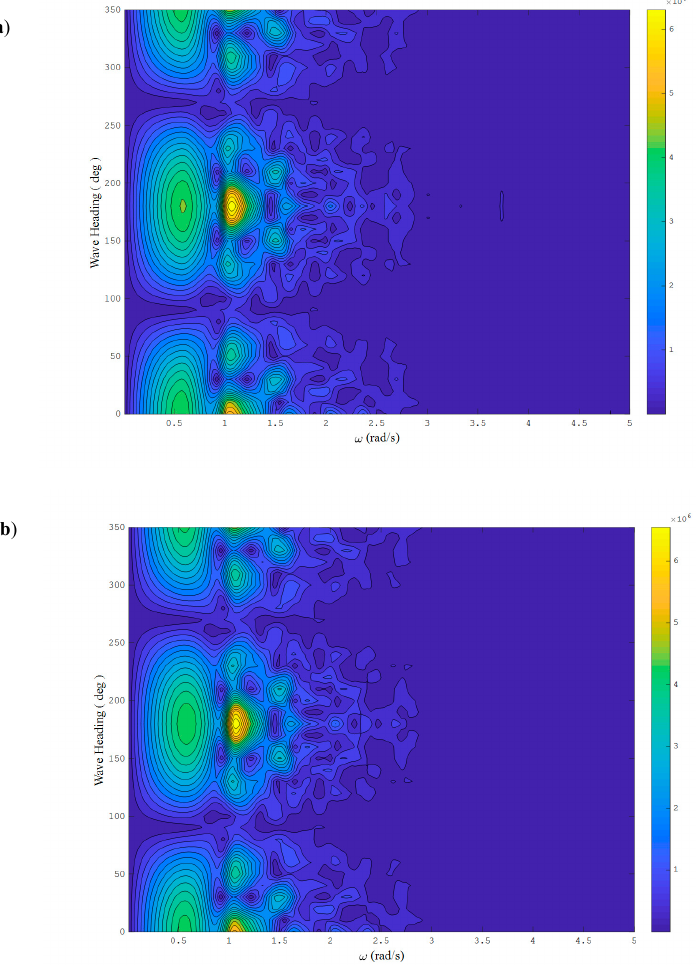
Figure 11. Modulus of the wave excitation force in x -direction acting on the OC4 DeepCwind floater as a function of the wave angular frequency ω and wave headings β , computed by ( a ) HAMS and ( b ) Hydrostar ® , respectively.